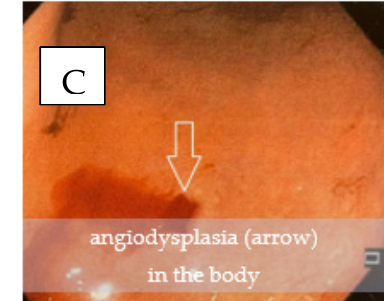
Figure 1. Gastroscopy images. ( A )—blood between the folds of the stomach; ( B , D )—endoclips; ( C , E )—angiodysplasias of the body. The patient was treated with a proton pomp inhibitor infusion and iron infusion. She was discharged with no signs of GI bleeding, normalized anemia parameters and diagno- sis of HHT. A family history of epistaxis or any other potential HHT manifestation is un- known. In order to identify the underlying genetic mutation and enroll first-degree rela- tives to further genetic testing, the patient was referred to mutational analysis of the HHT- causing genes. Due to the fact that the patient did not manifest any other HHT-related symptoms and that the instrumental screening discloses no silent AVMs in other organs, the “watch-and-wait strategy” was applied. Our patient seems to represent an HHT case displaying diagnostic delay, a phenomenon typically occurring in Osler-Weber-Rendu syndrome [16], as the diagnosis was established after 11 years of unexplained nosebleeds. After a six-month control of the patient’s situation, it has been found that she has experi- enced two episodes of epistaxis treated symptomatically (tranexamic acid 500 mg 3 times a day). 4. Discussion Osler-Weber-Rendu syndrome is named after Sir William Osler (Canadian physi- cian), Frederick Parkes Weber (English dermatologist) and Henri Jules Louis Marie Rendu (French dermatologist) who independently described the condition on the cusp of the 19th and 20th centuries [17]. In June 1999, the Curaçao criteria were established to diagnose this disease [3]. Nowadays, while diagnosing HHT, some difficulties may be encountered as it is fur- ther influenced by socioeconomic and geographical factors (a higher incidence in Afro- Caribbean residents of Curaçao and Bonaire) [2,6]. Nevertheless, as the awareness of this condition rose since the moment it had been discovered and described in the literature, the reported proportion of HHT cases rose as well. In 2016, six countries set up a working group dedicated to HHT within what became the European Reference Network on Rare Multisystemic Vascular Diseases [18].